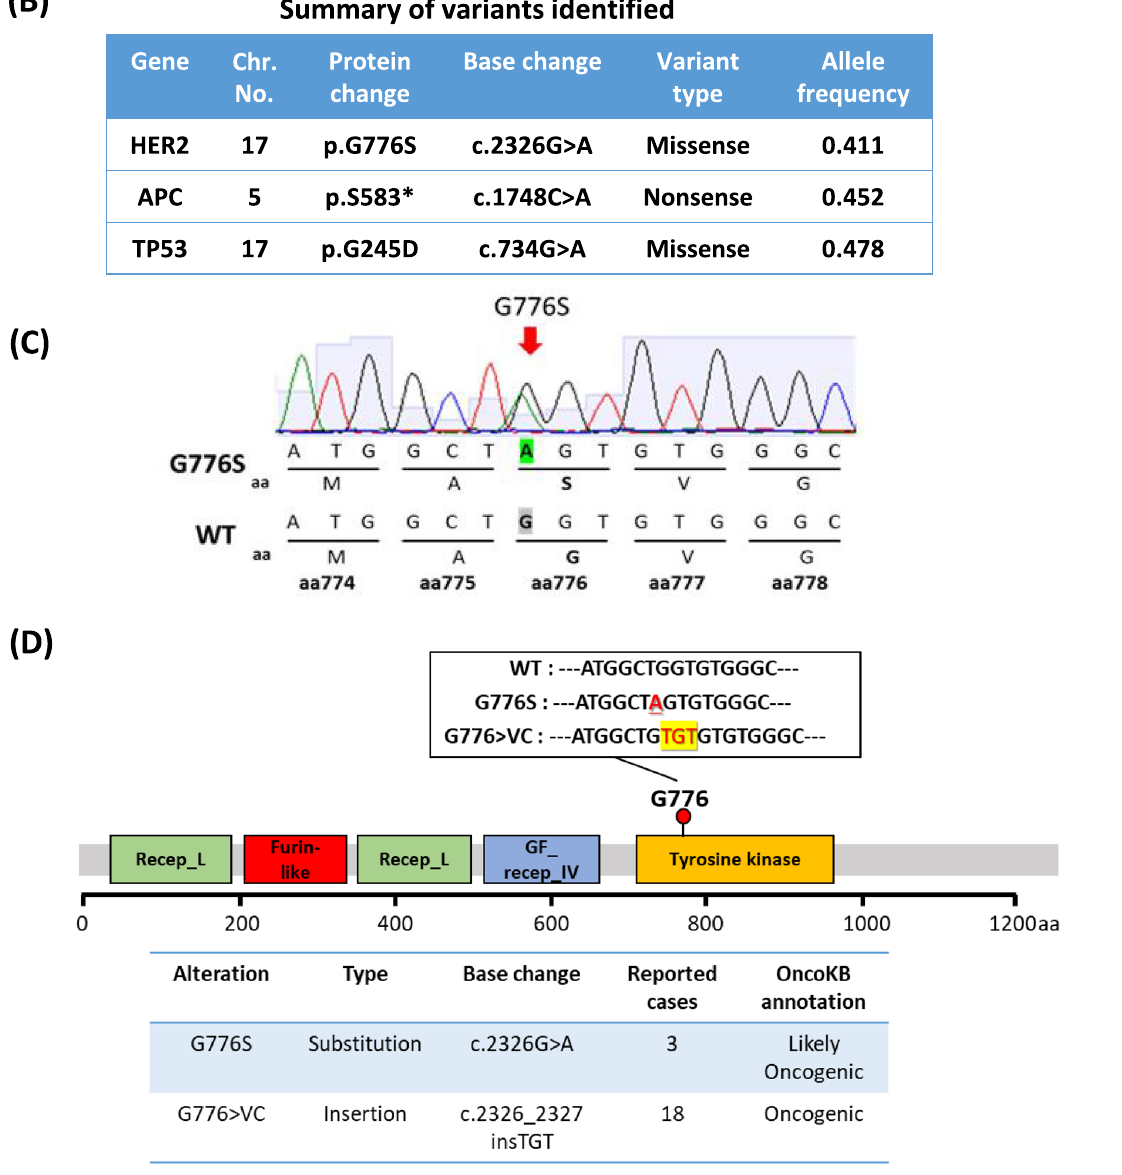
Figure 1. Genetic characteristics of a case of colorectal cancer harboring HER2 G776S mutation detected by clinical NGS. ( A ) Summary of the patient’s clinical profile. ( B ) Comprehensive genomic analysis report of the cancer of the patient. Positive biomarkers are shown. ( C ) Sanger sequencing of a part of HER2 gene of the cancer genome DNA. The amino acid (a.a.) sequence from 774 to 778 is shown. The sequence of the corresponding wild-type (WT) site is also presented. The red arrow indicates the mutation position of G776S. ( D ) The mutation position of G776 in HER2 protein domains based on the COSMIC database. The nucleotide sequences of the WT, G776S and G776 > VC are described. The underlined part indicates a substitution mutation and the yellow background site indicates a short insertion. Recep_L, receptor L domain; Furin-like, furin-like cysteine-rich region; GF_recep_IV, growth factor receptor domain IV. In the lower part of the figure, the number of reports in the COSMIC database and annotations from OnkoKB (https:// www. oncokb. org/) are shown. The data are current as of April